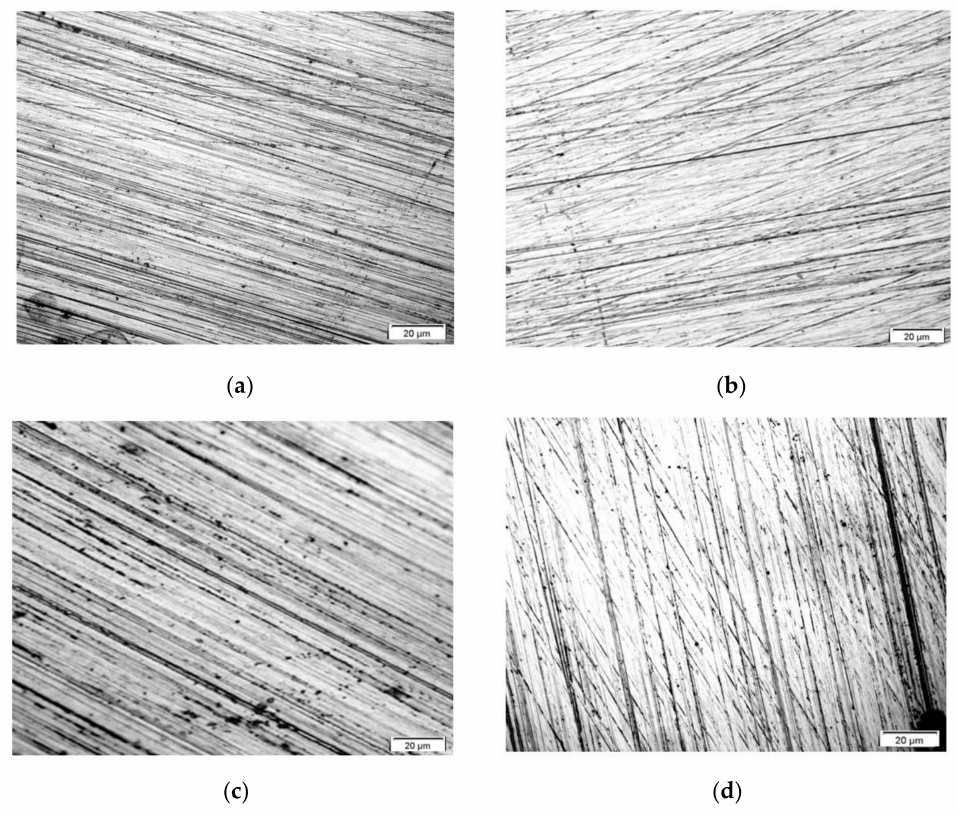
Figure 1. Coatings topography: VTMS/EtOH/AcOH ( a ), VTMS/EtOH/LiClO 4 ( b ), VTMS/EtOH/ H 2 SO 4 ( c ), VTMS/EtOH/NH 3 ( d ), ( ×